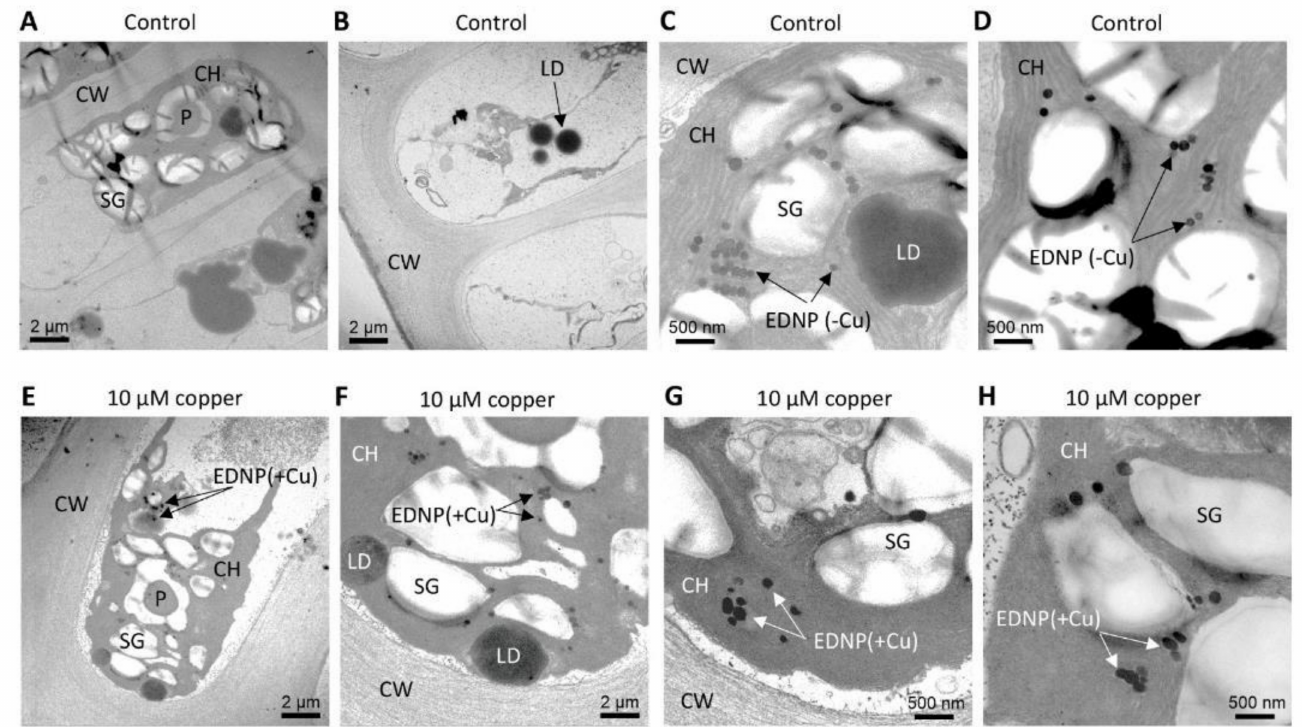
Figure 6. Pictures obtained by transmission electron microscopy (TEM) of a cell of U. compressa from a control site cultivated without copper addition in seawater (Cachagua, A – D ) and with 10 µ M of copper for 5 days ( E – H ) at a different magnification. Arrows indicate electrodense nanoparticles (EDNP) that do not contain copper ions (-Cu) and that contain copper ions (+Cu). Cell wall (CW); starch granules (SG); pyrenoid (P); lipid droplet (LD) and chloroplast